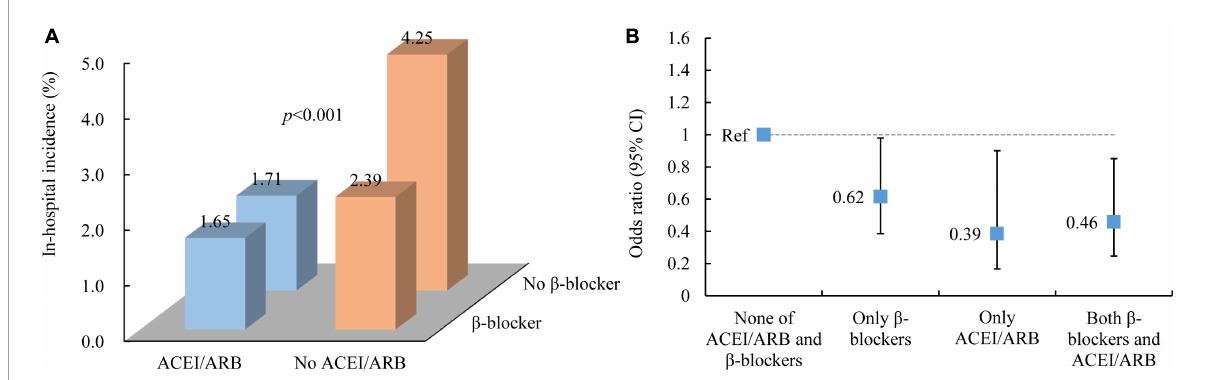
FIGURE3 In-hospital outcomes of AMI patients by early ACEI/ARB and β -blocker use. (A) In-hospital incidence of MACEs. (B) The association between ACEI/ARB and β -blocker use and in-hospital MACEs. ACEI, angiotensin-converting enzyme inhibitor; ARB, angiotensin receptor blocker; MACEs, major adverse cardiac